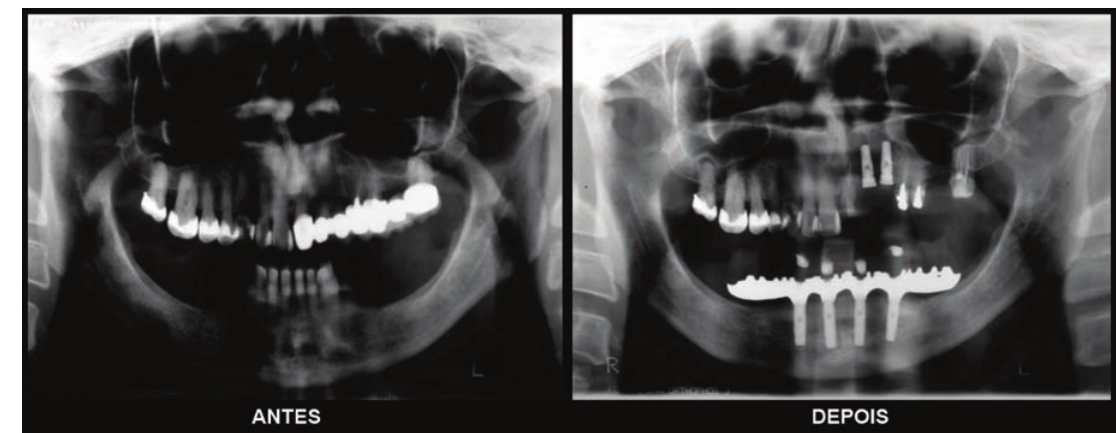
FIGURE 11 – Preoperative panoramic radiography and 4-month panoramic